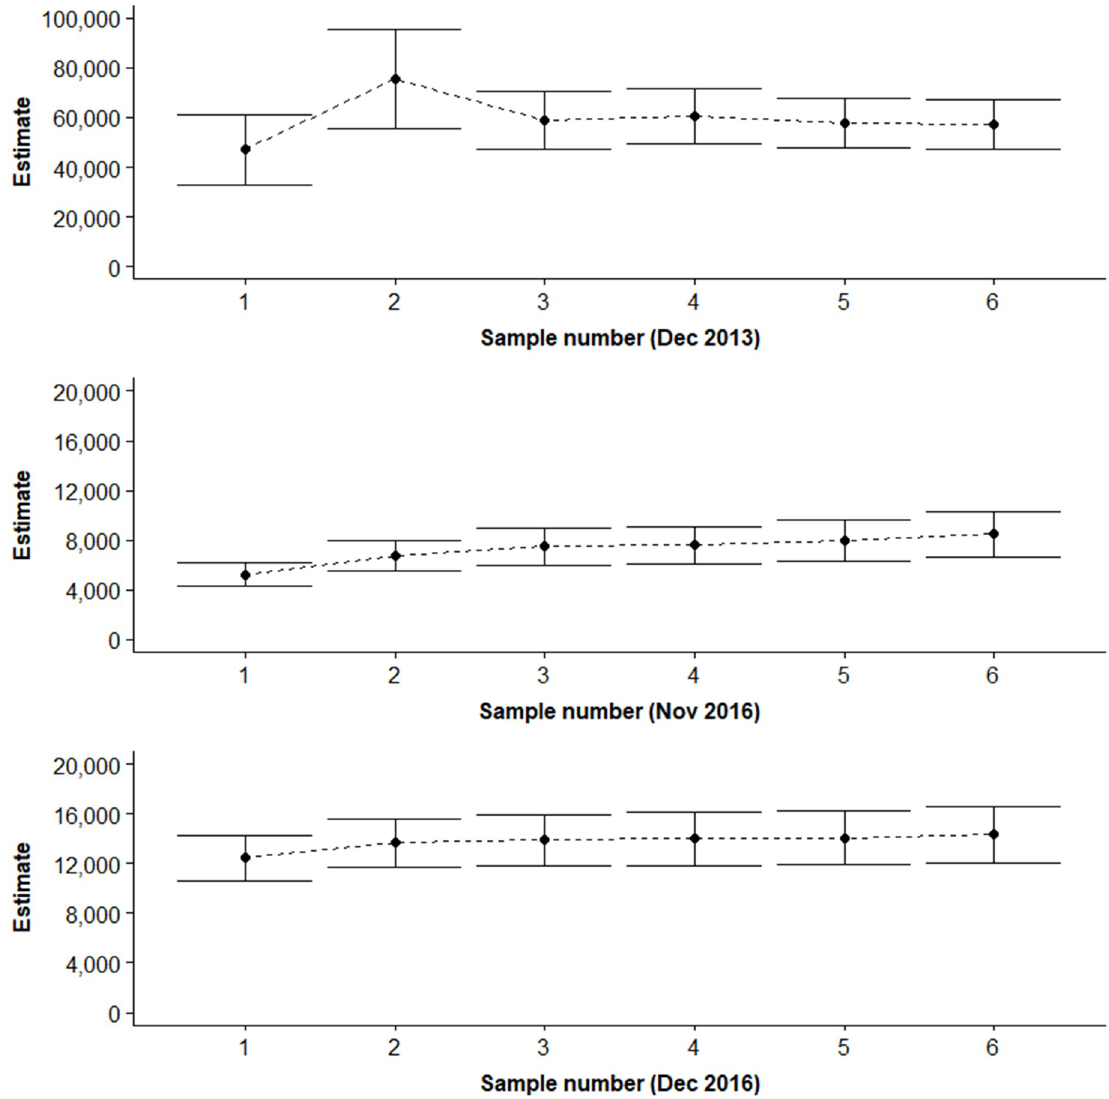
Fig 6. Influence of sample size on the Lincoln-Petersen estimate. Shown here are the estimates for the Surface observer method and the three sampling periods for which six samples were available ( ± 95% confidence